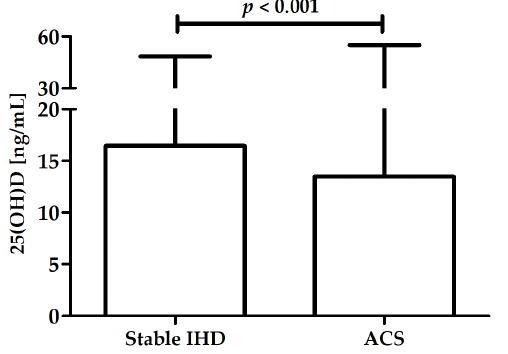
Figure 2. Difference in 25(OH)D between patients with stable IHD and ACS.